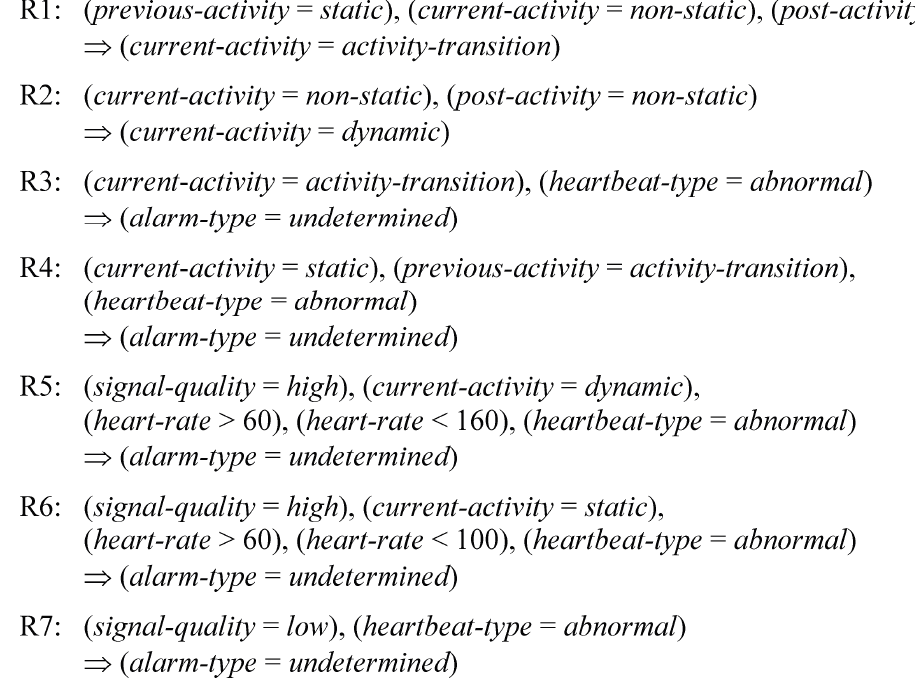
Figure 10. A rule set for detecting false